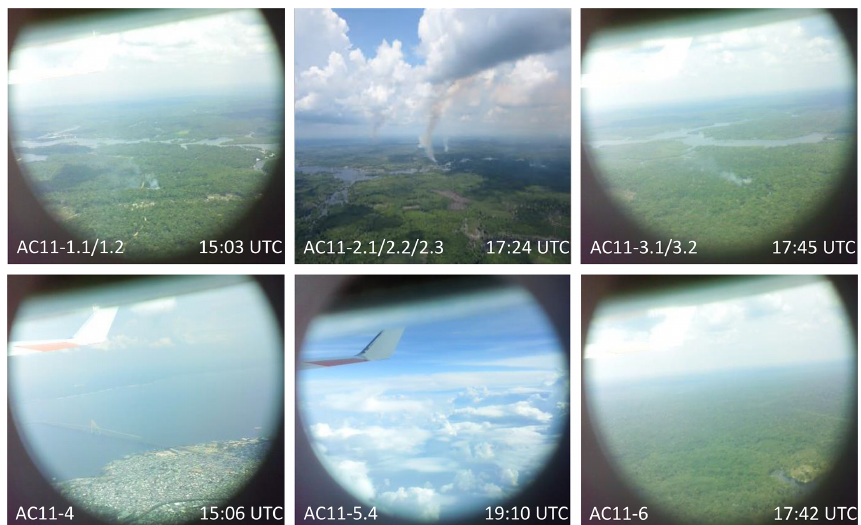
Figure 7. Images taken by the mini-DOAS camera during events 1–6 (as indicated in Figs. 6 and 8) for the flight AC11 with the UTC time given in each image. The second image was taken from the respective flight report. The video camera points in the same direction as the three limb telescopes of the mini-DOAS spectrometer, however with a much larger field of view of ∼ 46 ◦